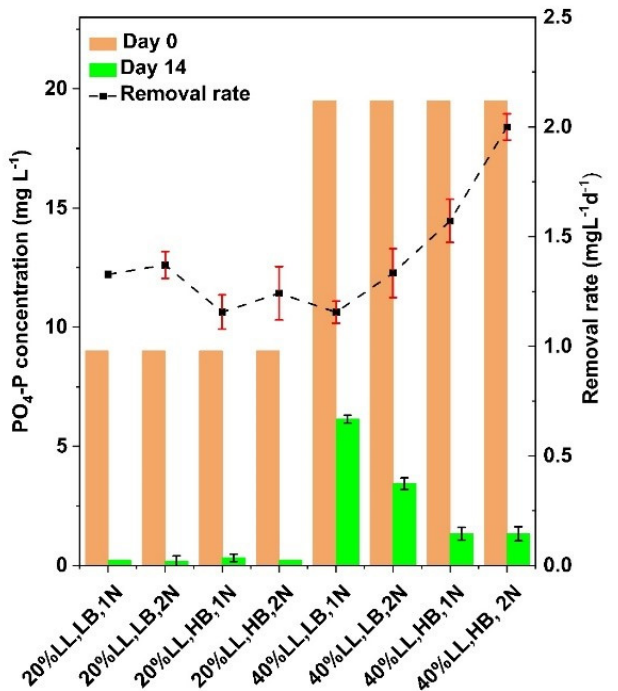
Figure 3. The initial and final concentration of PO 4 -P and removal rate by G. sulphuraria cultured in different LL media compositions for 14 days. Refer to Table 1 for LL media composition Table 3. Statistically significant regression models.